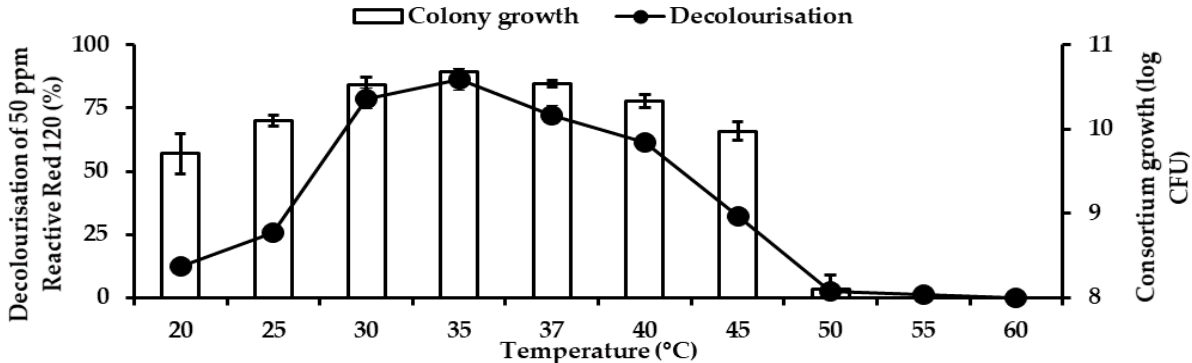
Figure 12. Effects of temperature on decolourisation of 50 ppm Reactive red 120 by consortium JR3. Data represent mean ± SD, n = 3.